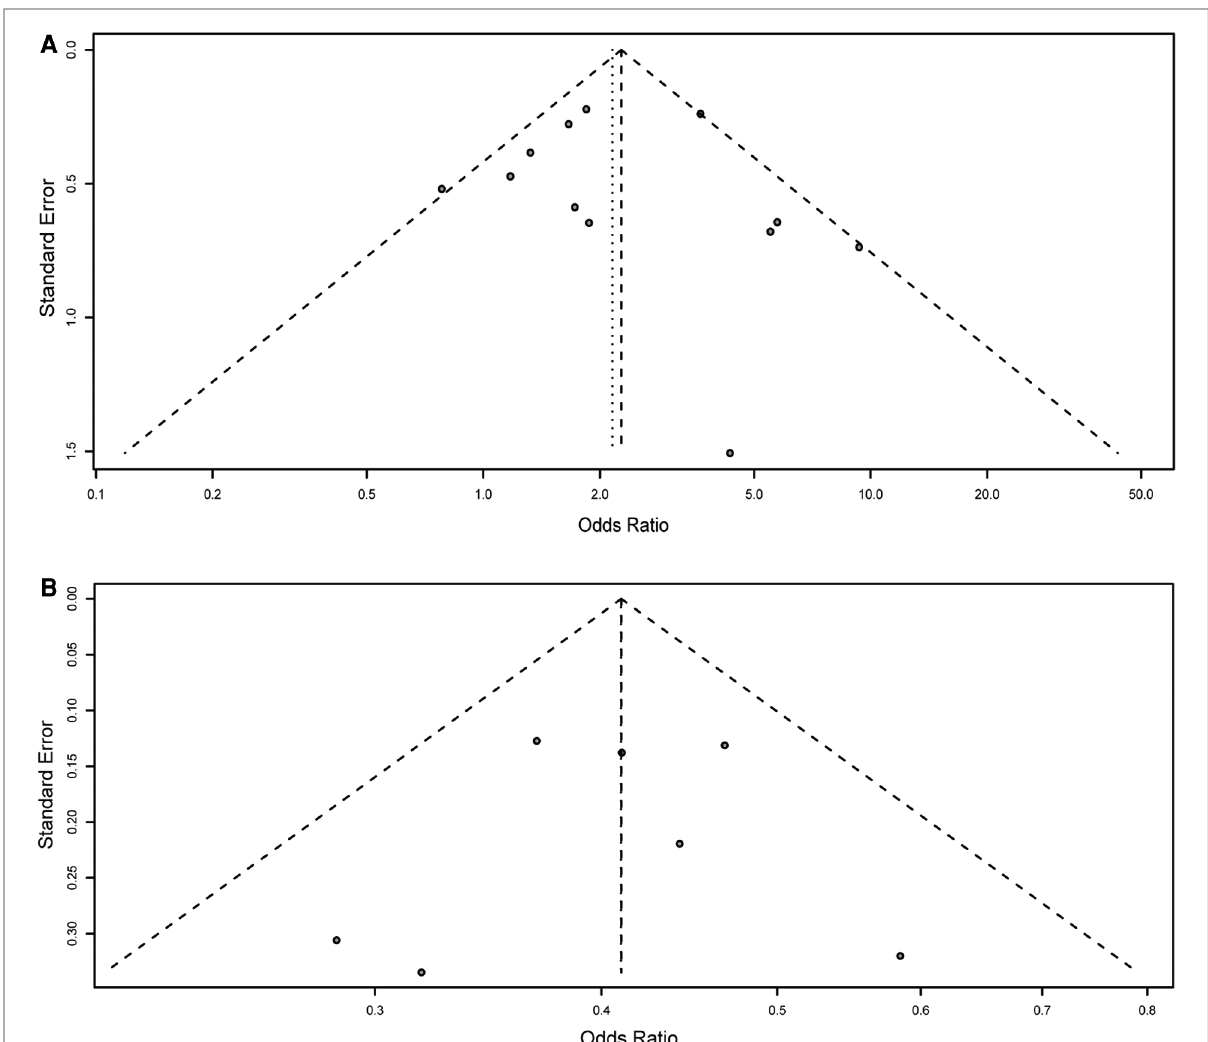
FIGURE 4 Funnel plot for the detection of the publication bias for association of rs2435357 and rs2506030 polymorphisms of the RET gene with HSCR risk. ( A ) rs2435357 (heterozygous model); ( B ) rs2506030 (dominant